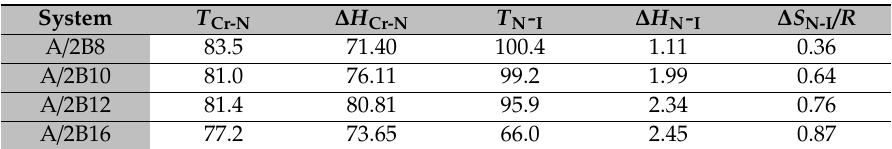
Table 1. Phase transition temperatures (T, ◦ C), enthalpy of transitions ( ∆ H, kJ / mol), and normalized transition entropy ( ∆ S / R) of HBSMCs, A / 2Bn.